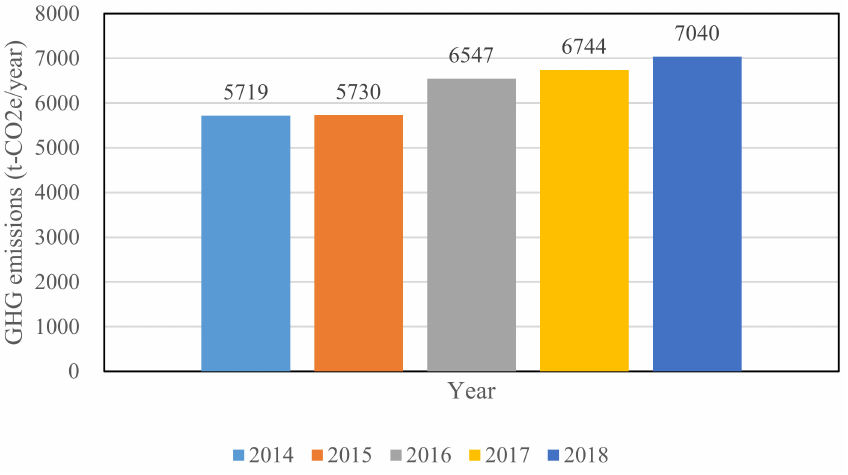
Figure 1. GHG emissions of Honjo city.